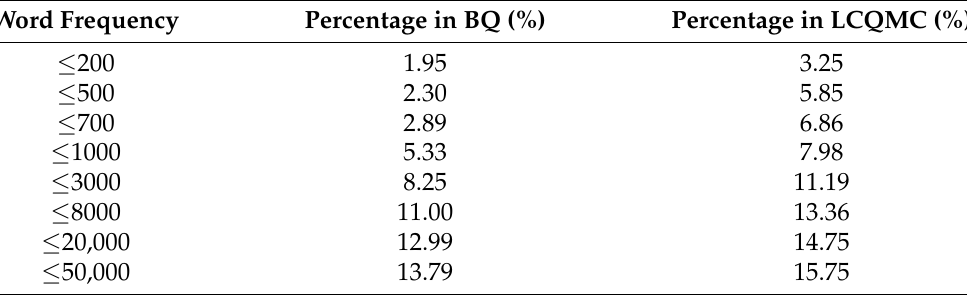
Table 5. The distributions of low-frequency words of BQ and LCQMC